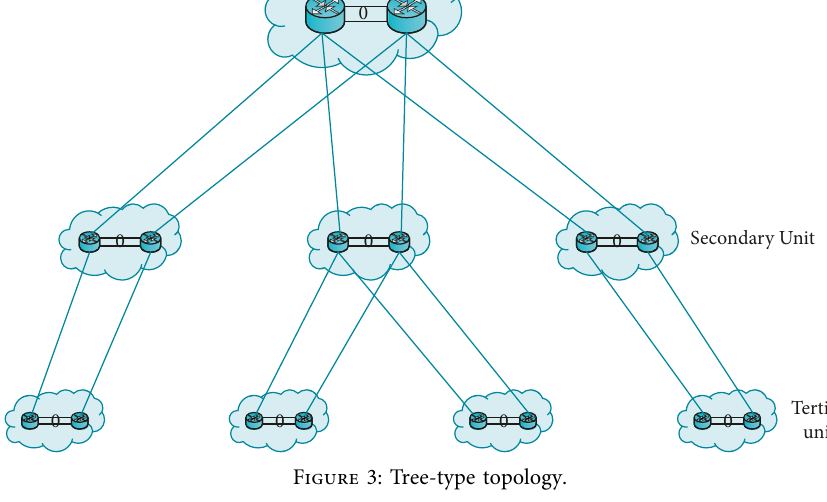
Figure 3: Tree-type topology.